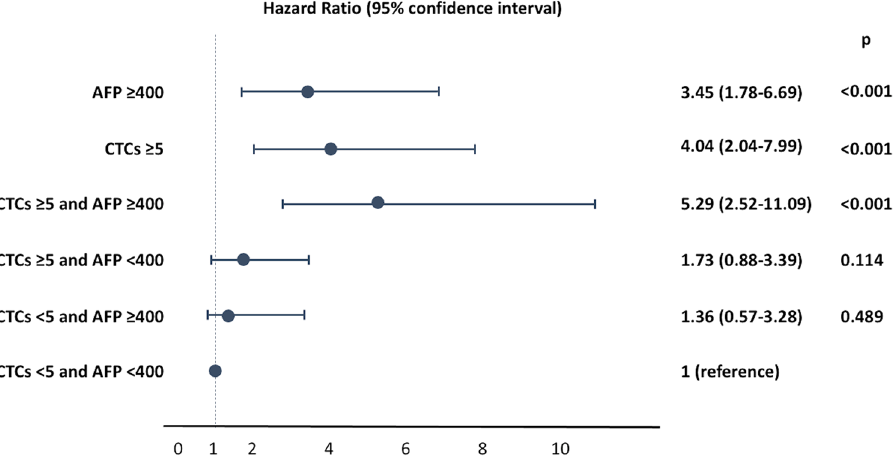
Figure 4. Association between combinations of CTCs and AFP and survival of HCC